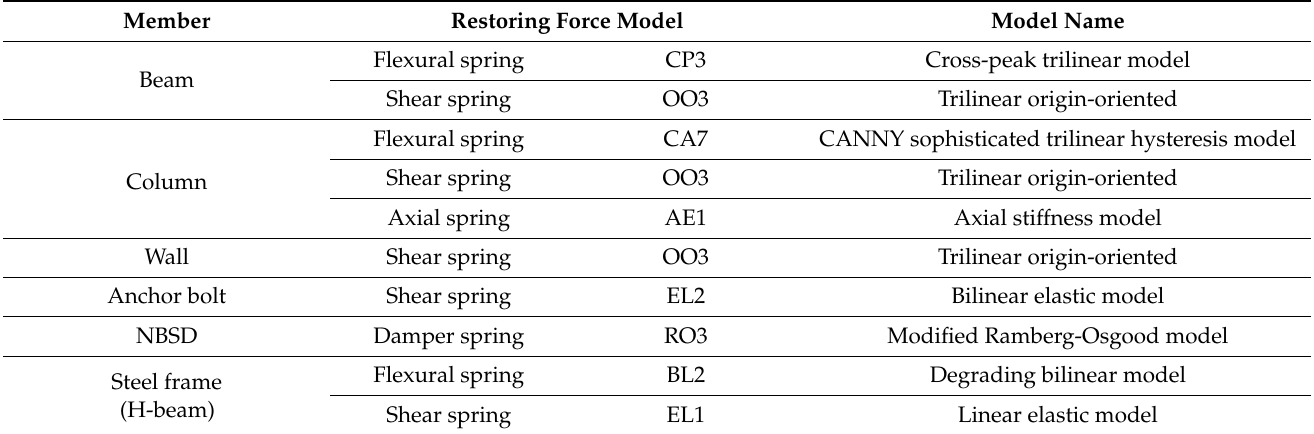
Table 12. Restoring force characteristics of each member used in the nonlinear dynamic